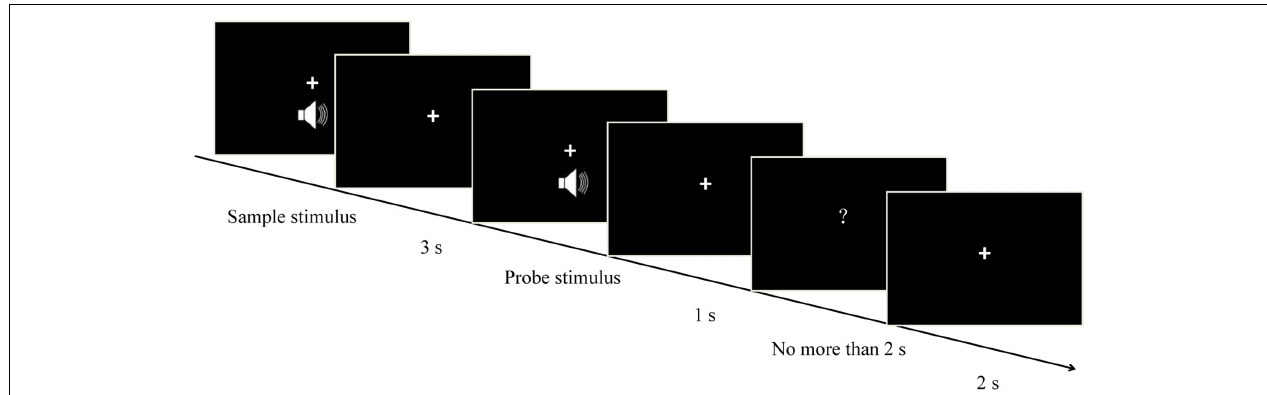
FIGURE 1 | Schematic representation of each individual trial. Each trial started with a pure tone (sample stimulus), which was randomly presented for 1, 2, 3, or 4 s. After a 3-s interval (the delay/maintenance phase), a second pure tone (probe stimulus) was presented randomly for one of three possible durations depending on the sample duration (i.e., sample – probe: 1–0.5 s, 1 s, 1.5 s; 2–1 s, 2 s, 3 s; 3–1.5 s, 3 s, 4.5 s; 4–2 s, 4 s, 6 s). Participants estimated whether the duration of the probe stimulus was shorter, equal to, or longer than that of the sample one, and correspondingly pressed “1,” “2,” or “3,”